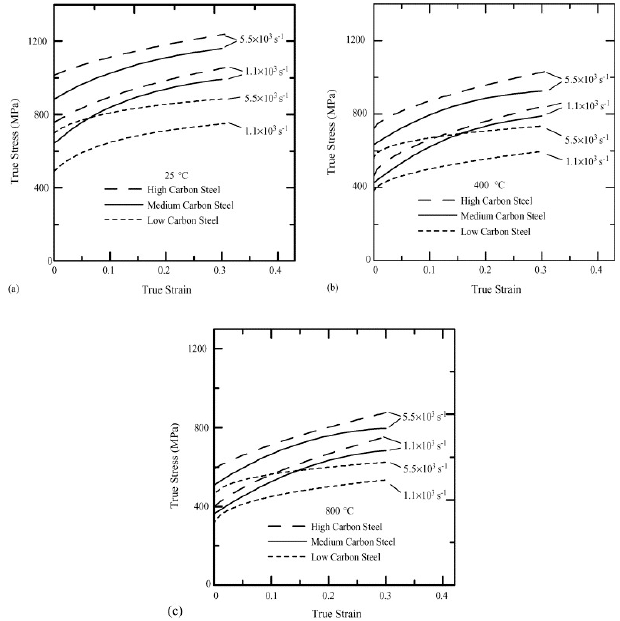
Figure 22. Stress–strain curves of S15C, S50C, and SKS93 at temperatures of ( a ) 25 °C; ( b ) 400 °C; and ( c ) 800 °C [123] .